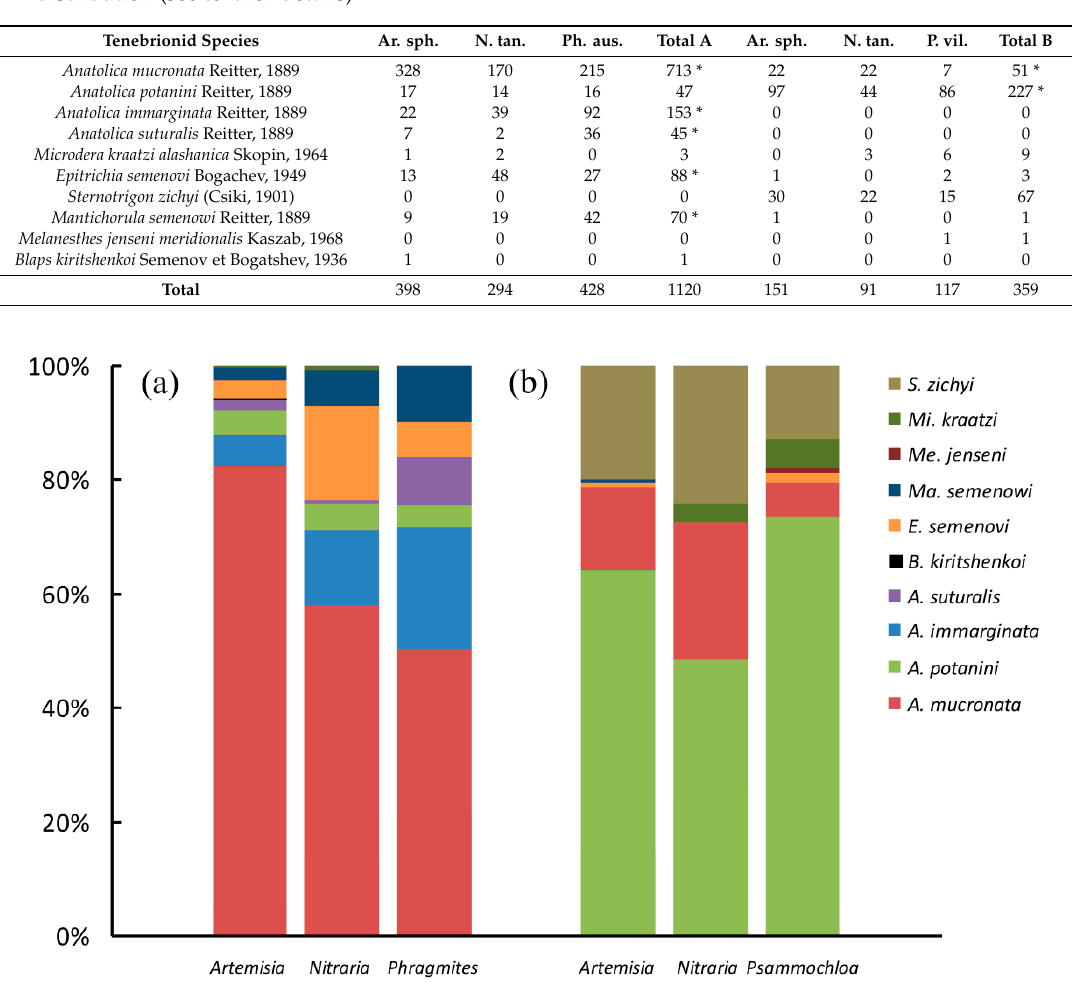
Figure 4. Proportion of the tenebrionid beetle species collected in two sites (A and B) in the Ulan Buh Desert (Gobi Desert, Inner Mongolia, China). For insect species names, see Table 1. The goodness-of-fit statistics of the OLS regression lines (Table 2) indicated that the geometric series fitted adequately all species ensembles (Figure 5) and the two whole communities (Figure 6). The lack of significance of the regression line for N. tangutorum in Site B is due to the small number